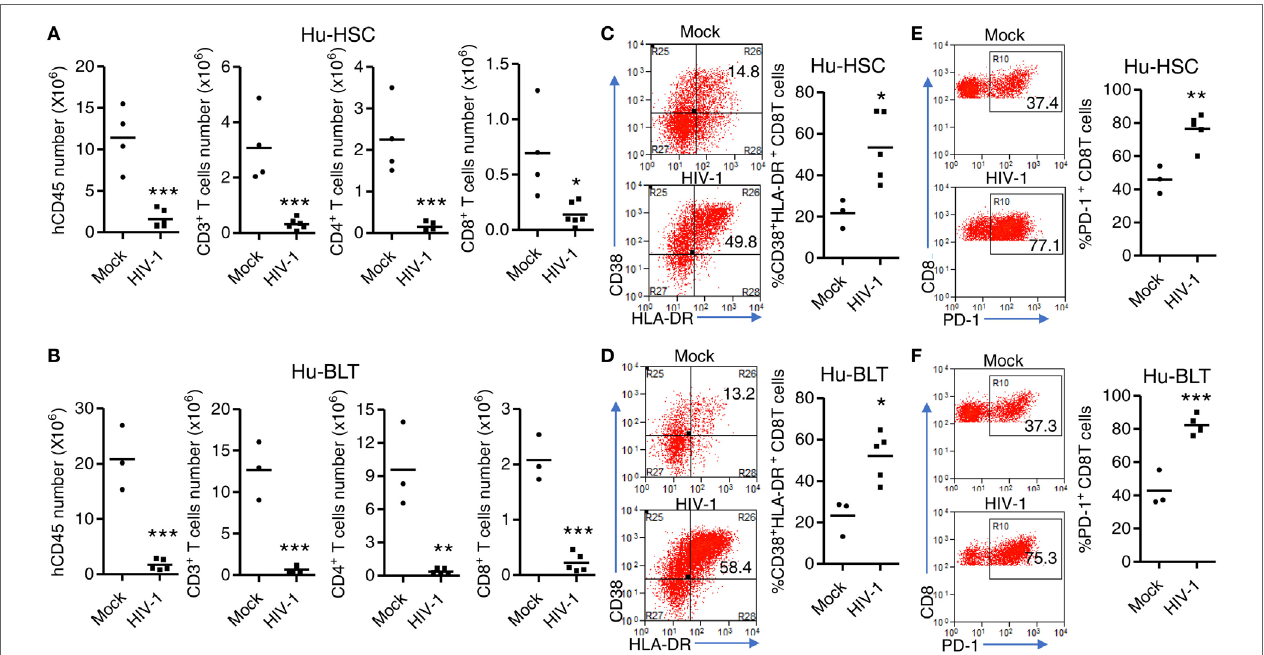
FigUre 6 | HIV-1-induced immunopathology in NRG-hu HSC and NRG-hu Thy/HSC mice. NRG-hu HSC and NRG-hu Thy/HSC mice were infected with HIV-1. Mice were sacrificed at 10 weeks postinfection. (a,B) Numbers of total human leukocytes, CD3 + T cells, CD4 T cells (CD3 + CD8 − ), and CD8 T cells (CD3 + CD8 − ) and in spleens of NRG-hu HSC (a) and NRG-hu Thy/HSC (B) mice. (c,D) Representative FACS plots and summarized data show the expression of CD38 and HLA-DR on CD8 T cells from spleen of NRG-hu HSC (c) and NRG-hu Thy/HSC (D) mice. (e,F) Representative FACS plots and summarized data show the expression of PD-1 on CD8 T cells from spleen of NRG-hu HSC (e) and NRG-hu Thy/HSC (F) mice. Shown are representative data from n = 3 (NRG-hu HSC/ Mock), n = 5 (NRG-hu HSC/HIV-1), n = 3 (NRG-hu Thy/HSC/Mock), and n = 5 (NRG-hu Thy/HSC/HIV-1) mice reconstituted with HSCs/thymus from the same donor. Each dot represents one individual mouse; bars indicate mean (* P < 0.05, ** P < 0.01, and *** P < 0.001, by unpaired, two-tailed Student’s t -test).